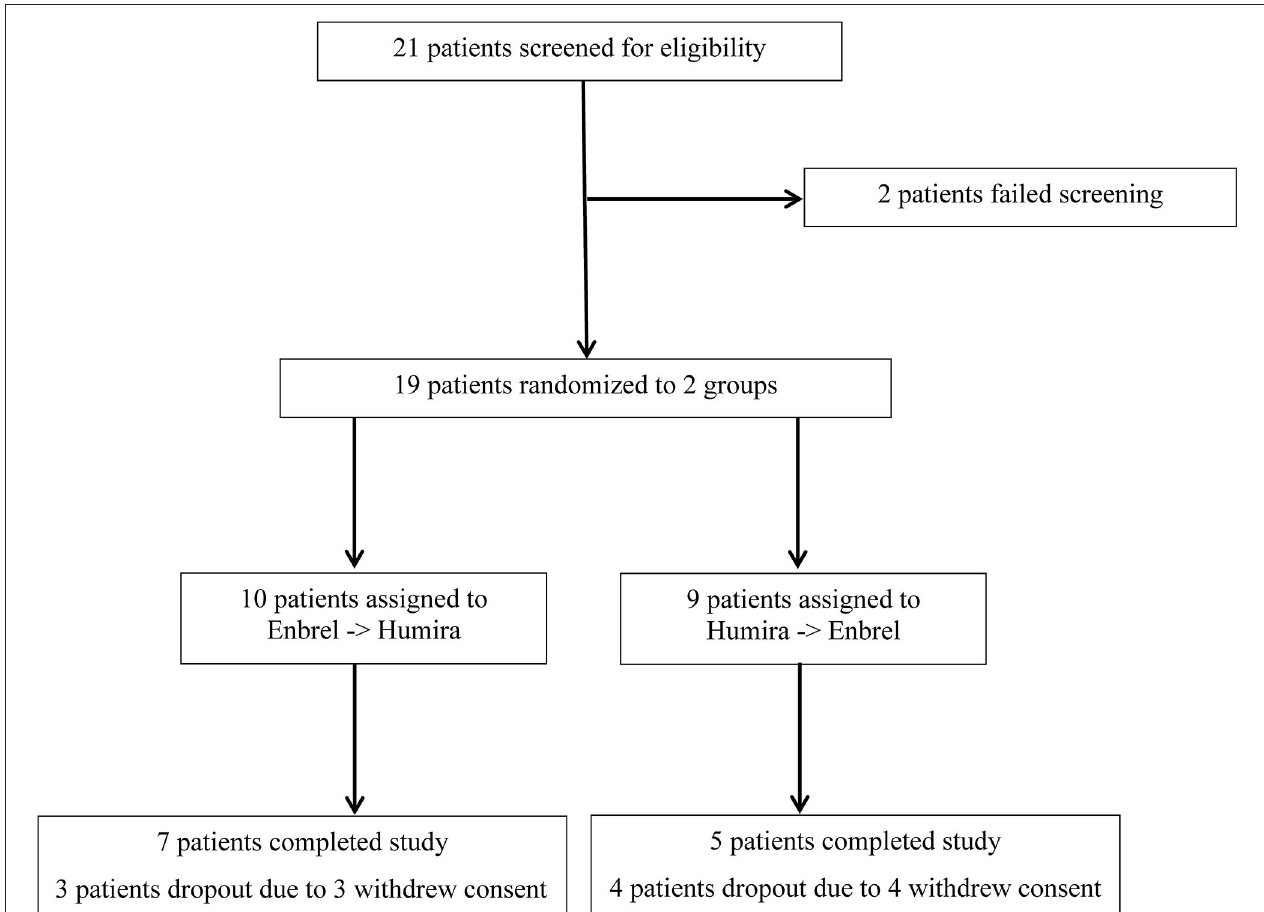
FIGURE 1 | Screening procedure for an eligible patient enrolled for the treatment arm and the control arm.